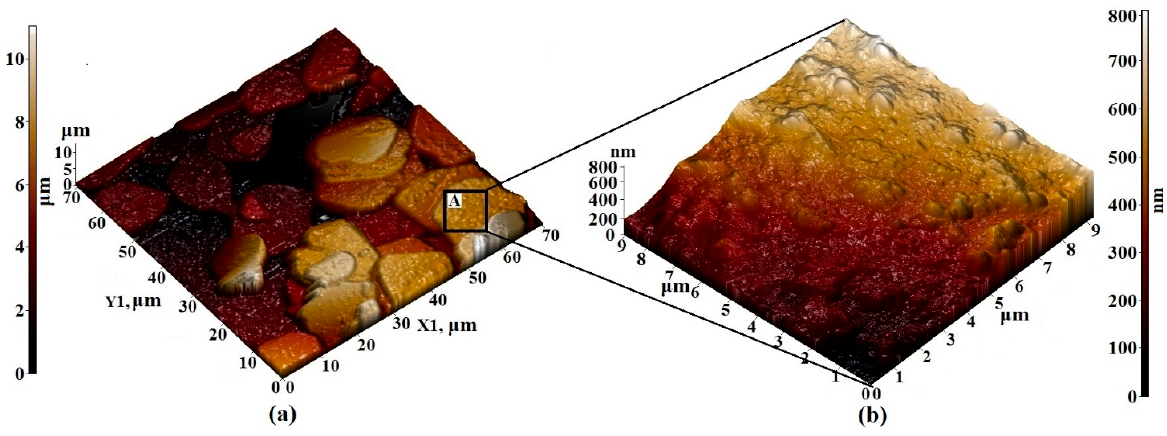
Figure 7. AFM 3D—image of the surface topology of ( a ) 70 × 70 μ m 2 and ( b ) 9 × 9 μ m 2 sections of the Pr 3 Fe 5 O 12 film formed on an Al 2 O 3 substrate.